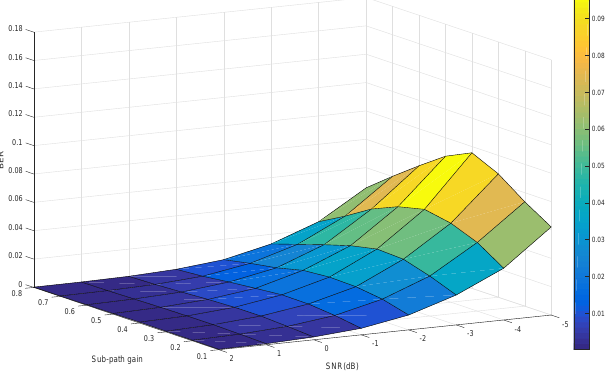
Figure 11. BER for normalized symbol joint decision as a function of SNR and sub-path gain. Figure 12 indicates that the BER is a function of SNR and sub-path gain as independent variables when the demodulator uses the symbol joint decision.